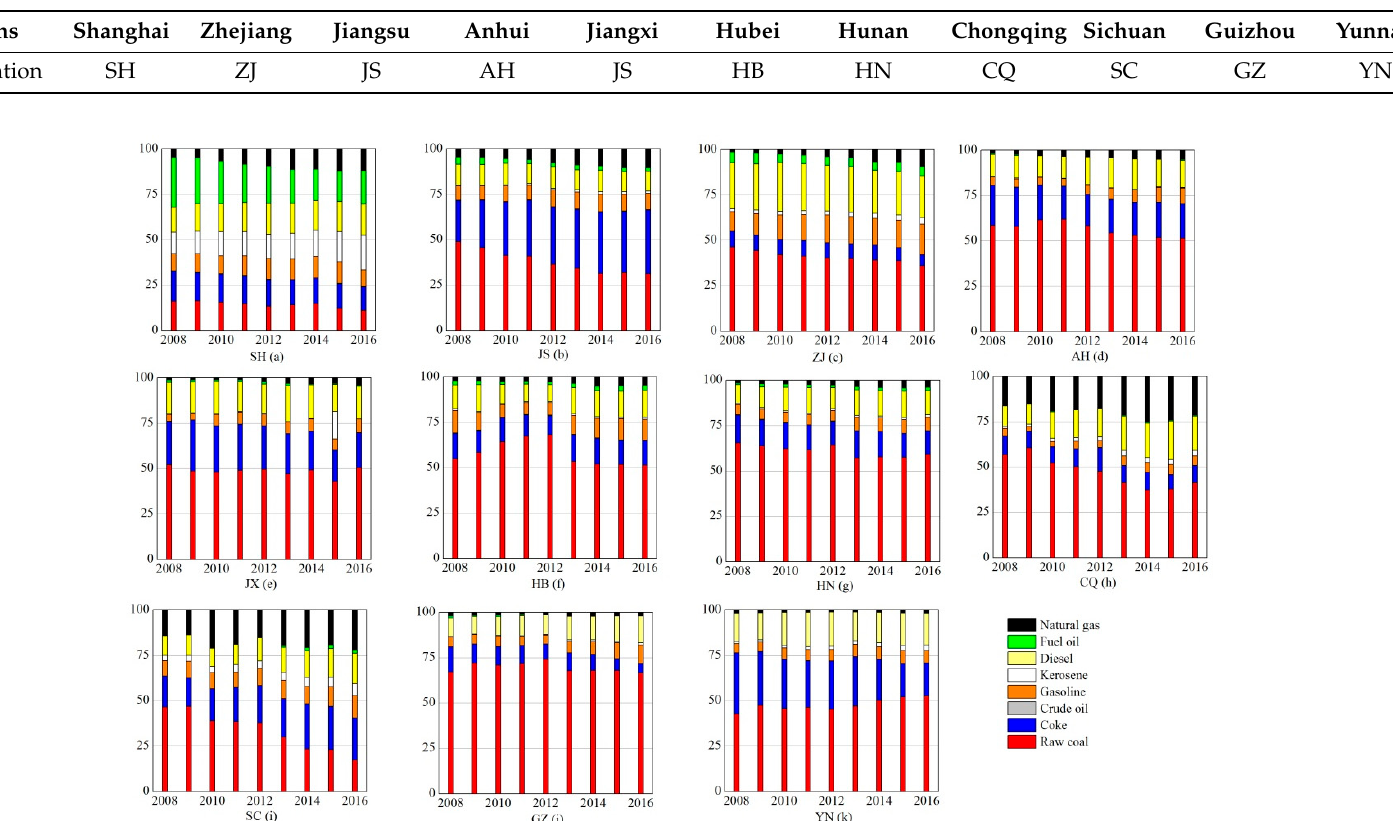
Figure A1. Proportion of energy structure in the YREZ during 2008–2016. ( a ) SH; ( b ) JS; ( c ) ZJ; ( d ) AH; ( e ) JX; ( f ) HB; ( g ) HN; ( h ) CQ; ( i ) SC; ( j ) GZ; ( k )